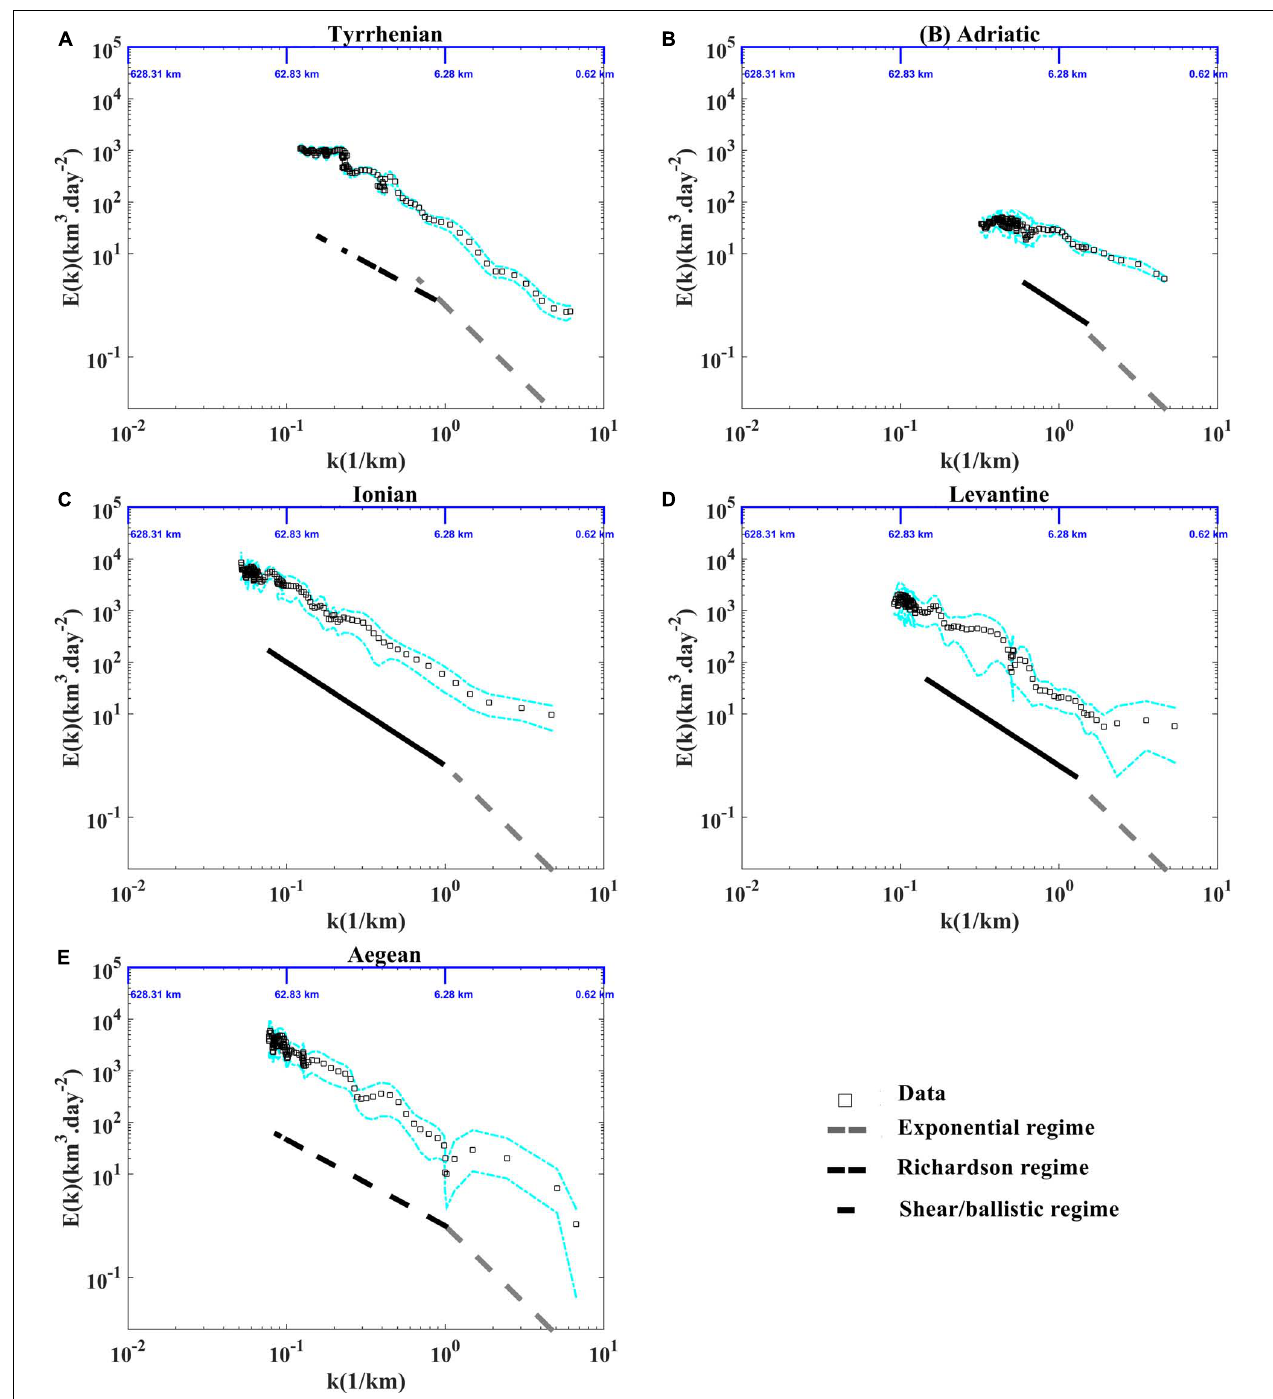
FIGURE 12 | Energy spectra in function of wave number (A) in the Tyrrhenian, (B) the Adriatic, (C) the Ionian, (D) the Levantine, and (E) the Aegean sub-basins. The exponential, the Richardson and the shear/ballistic regimes are shown with the dashed gray, dashed black and black lines, respectively. The dashed cyan lines indicate the 90% confidence intervals from bootstrap resampling, give a rough idea of the uncertainties for the statistics.